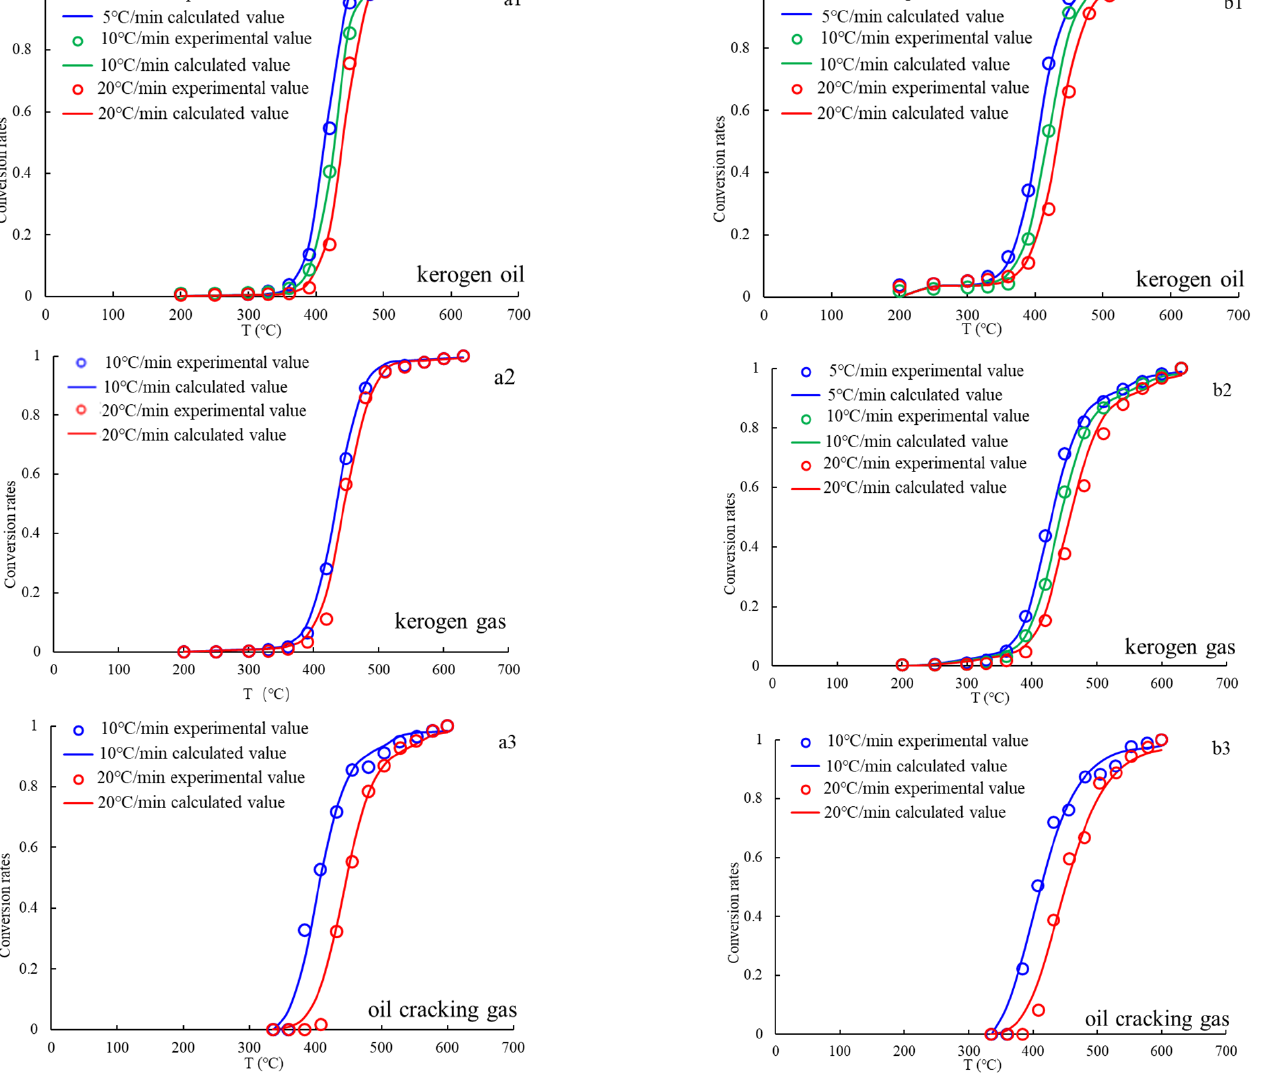
Figure 9. Relationship between temperature and hydrocarbon conversion rate of kerogen (( a1 – a3 ). type II 1 ; ( b1 – b3 ). type II 2 ).